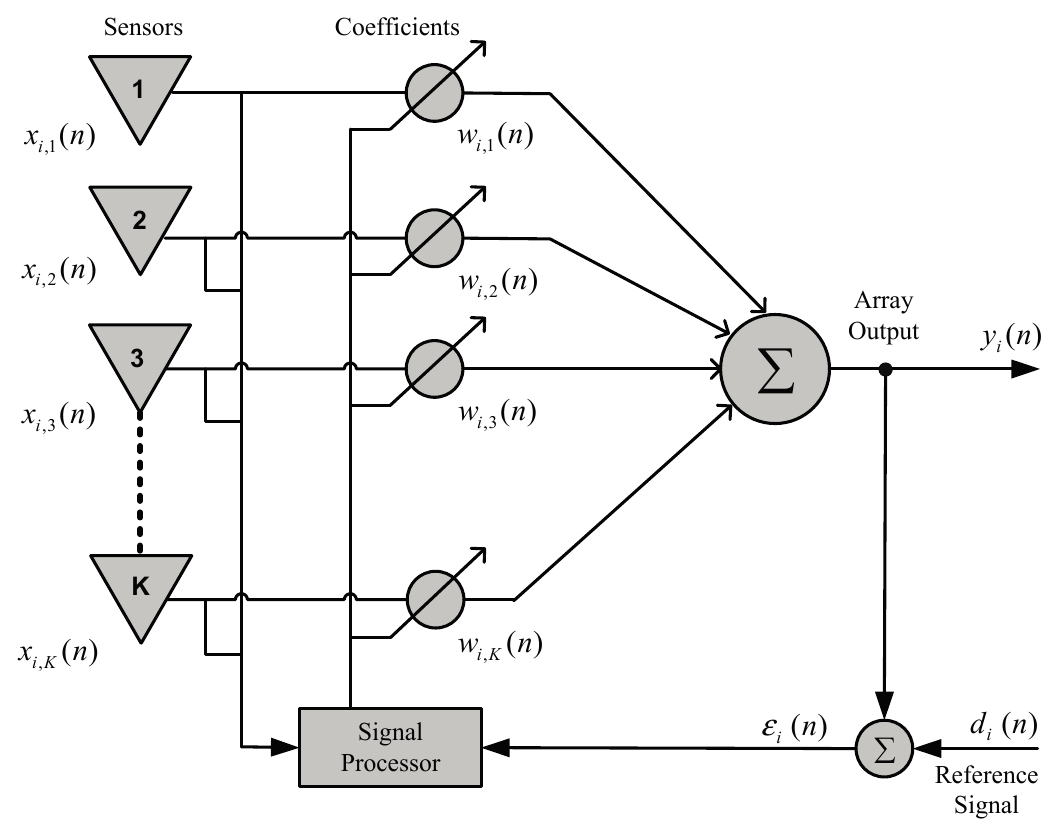
Figure 1. Functional diagram of an adaptive